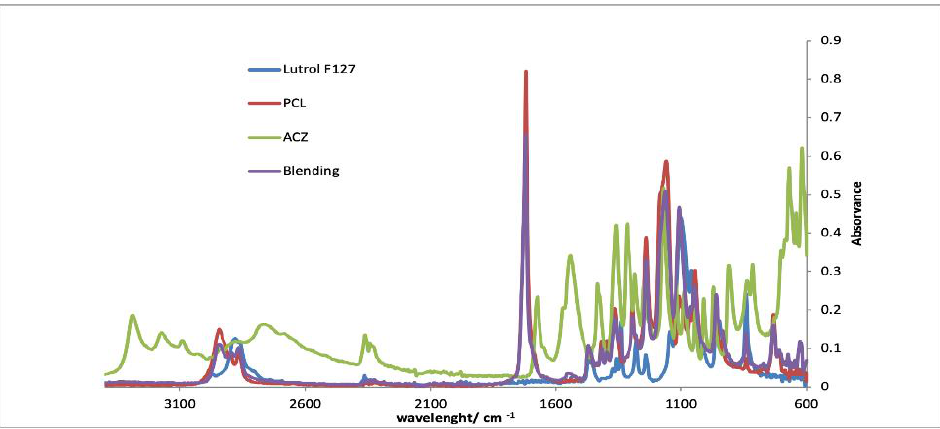
Figure 7. FTIR spectra of blending implants compared with PCL, Lutrol F127 and acetazolamide.